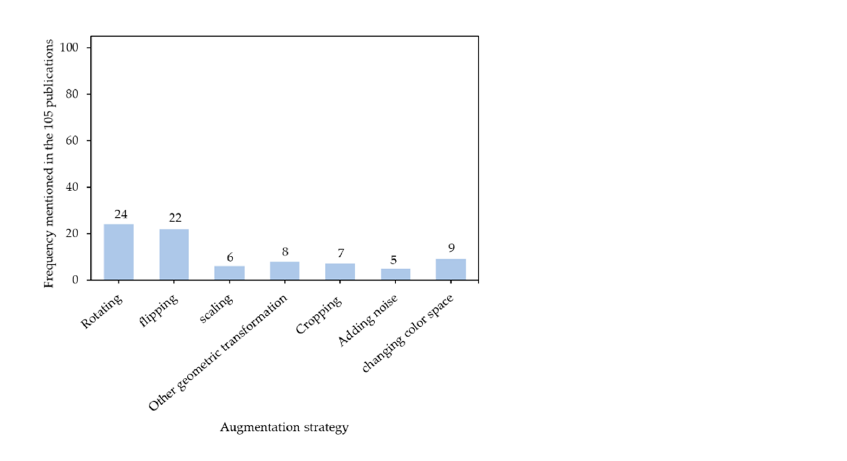
Figure 9. Frequency of different augmentation strategies in the 105 publications. Other geometric transformation includes distorting, translating, shifting, reflecting, shearing, etc.